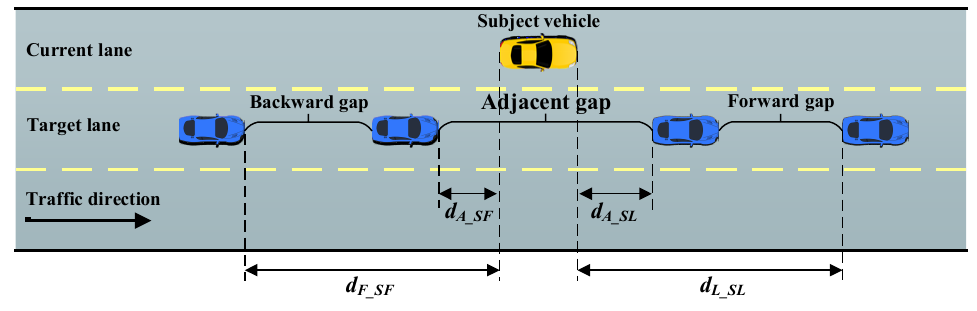
Figure 3. Schematic illustration of the lane-changing model. M LCD